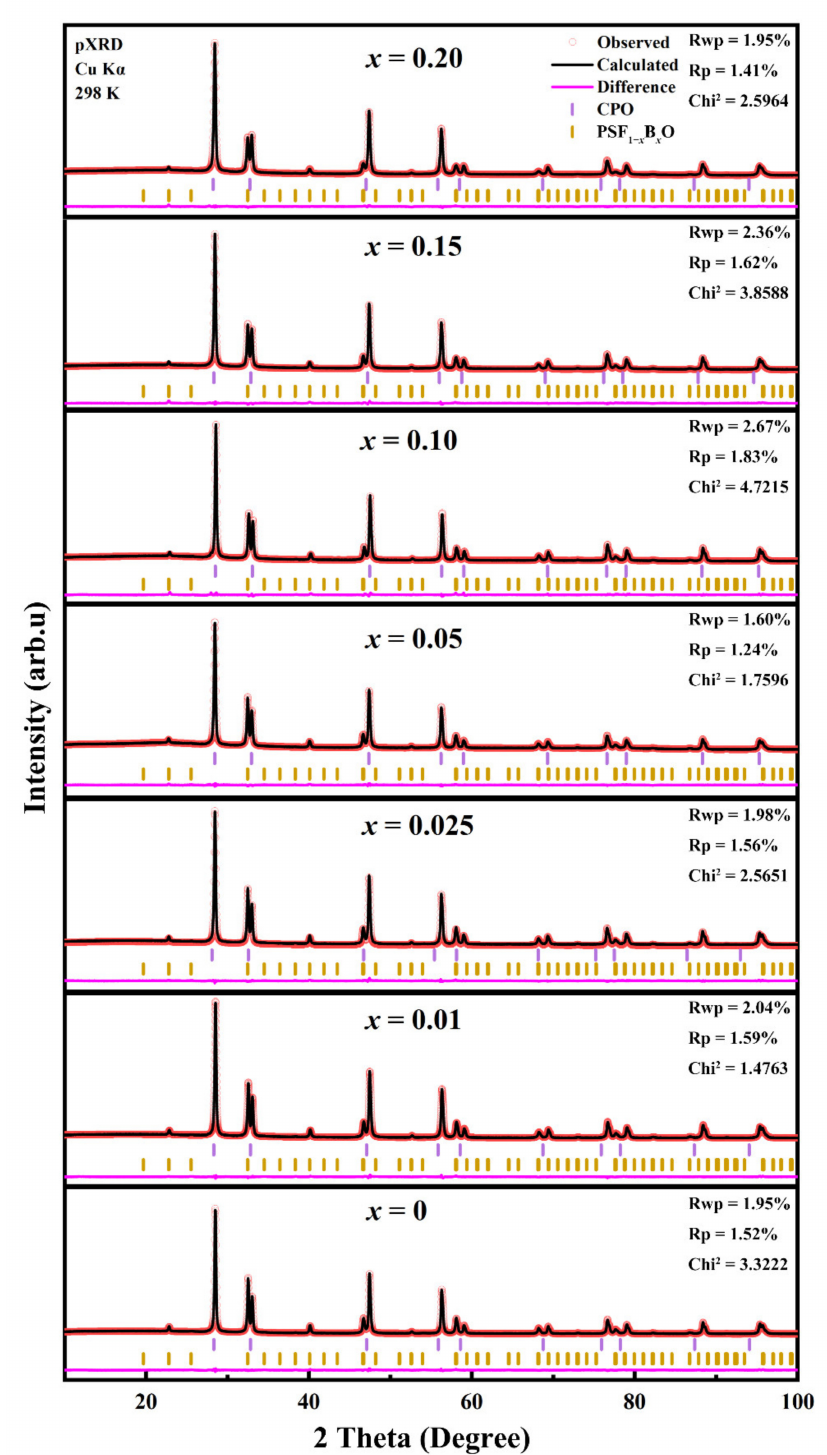
Figure 1. XRD patterns of 60CPO-40PSF 1 − x B x O ( x = 0, 0.01, 0.025, 0.05, 0.10, 0.15, 0.20) powders obtained by calcined at 950 ◦ C for 10